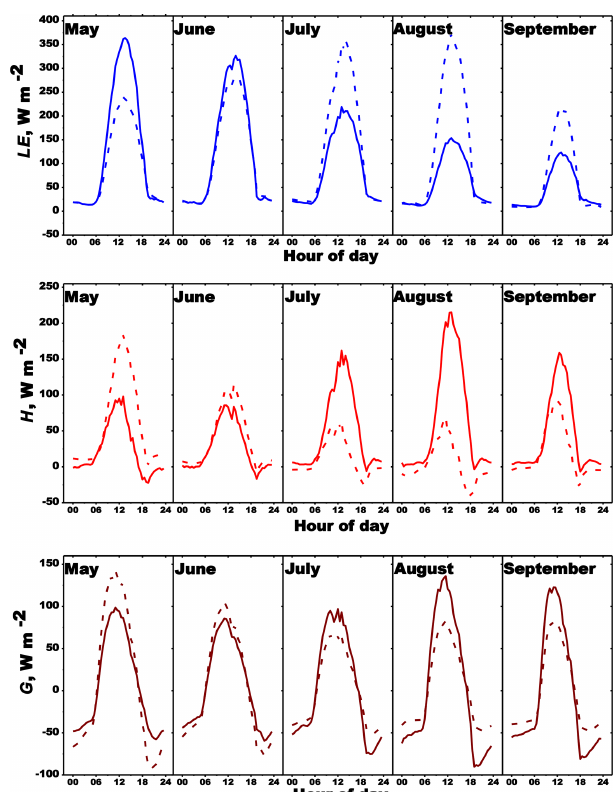
Figure 2. Simulation results of Noah-MP LSM for latent heat flux ( LE ), sensible heat flux ( H ) and ground heat flux ( G ). Simulations were performed for two types of crops: early covering (solid line) and late covering (dashed line). Time is local